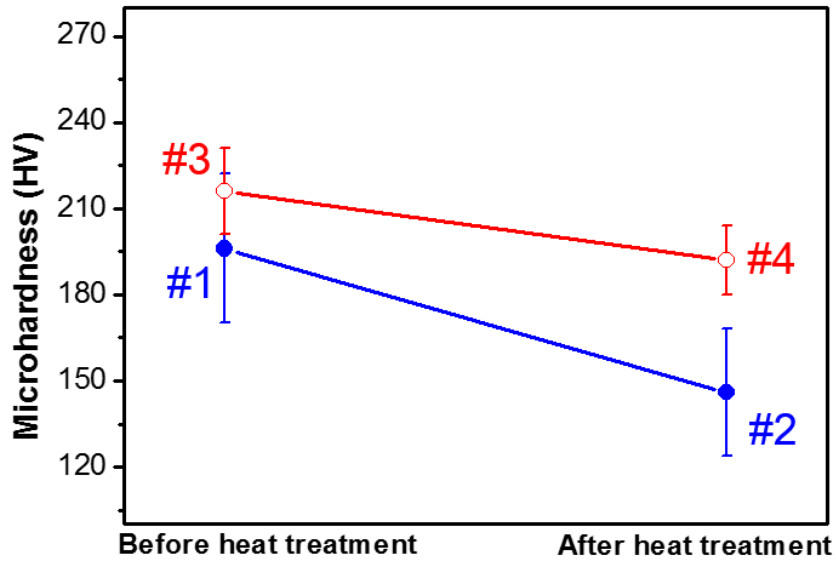
Figure 11. Microhardness of Ni-based alloys before and after heat treatment.